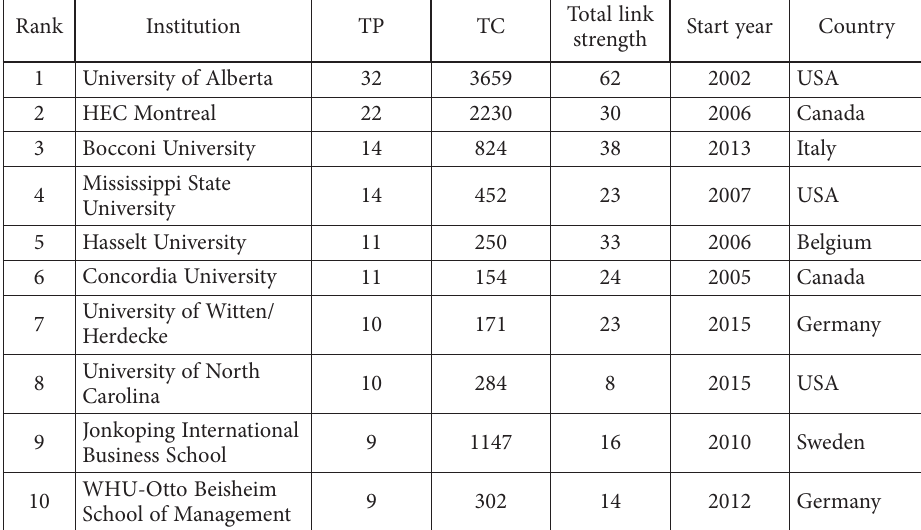
Table 4. The most productive institutions